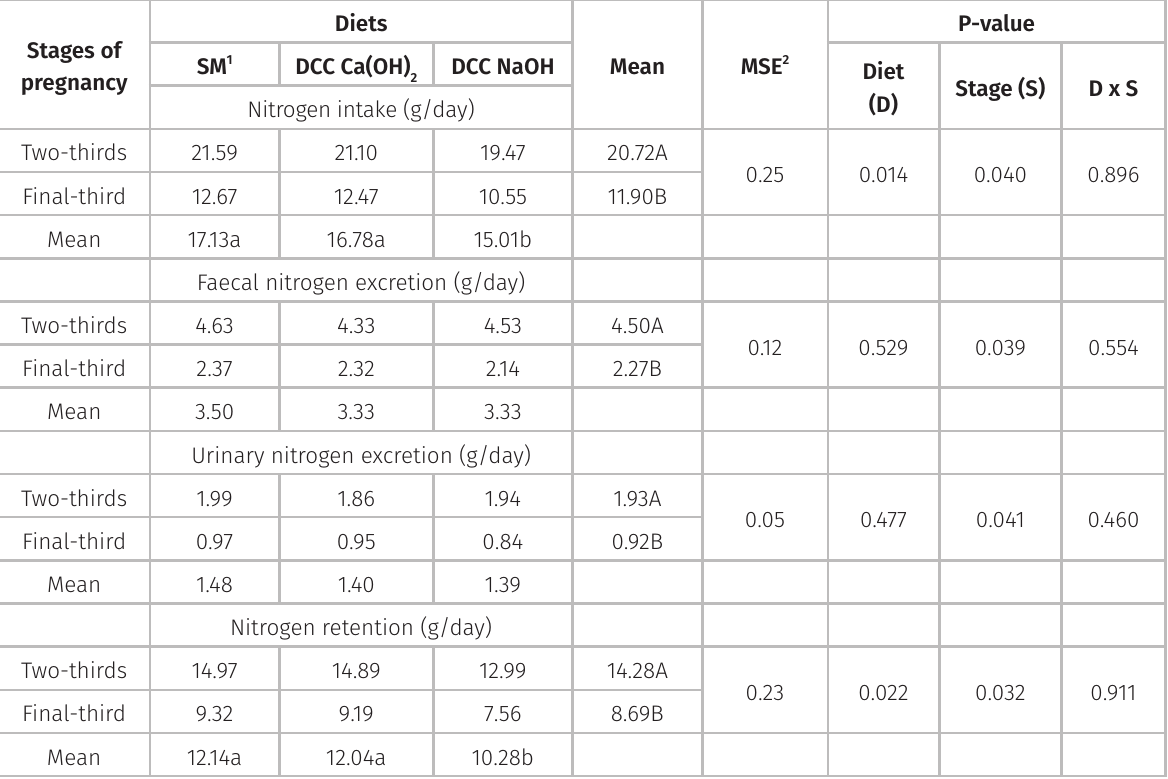
Table VI. Nitrogen balance of goats fed with detoxified castor cake (DCC) at different stages of pregnancy.